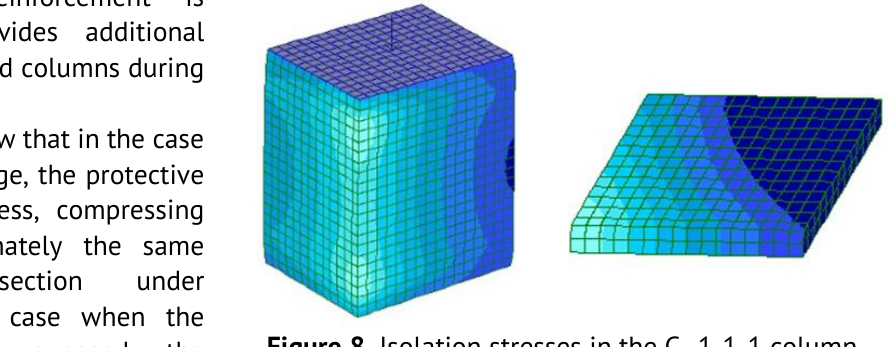
Figure 8. Isolation stresses in the C -1-1-1